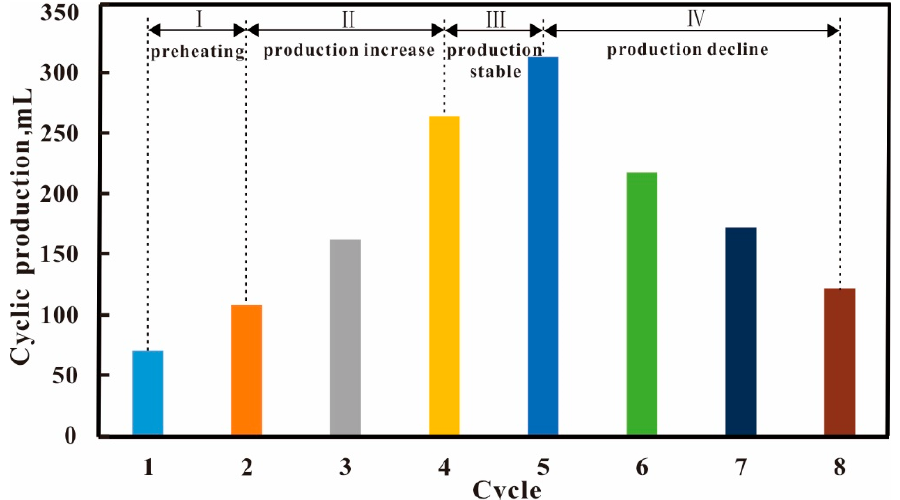
Figure 9. Production distribution in each cycle.